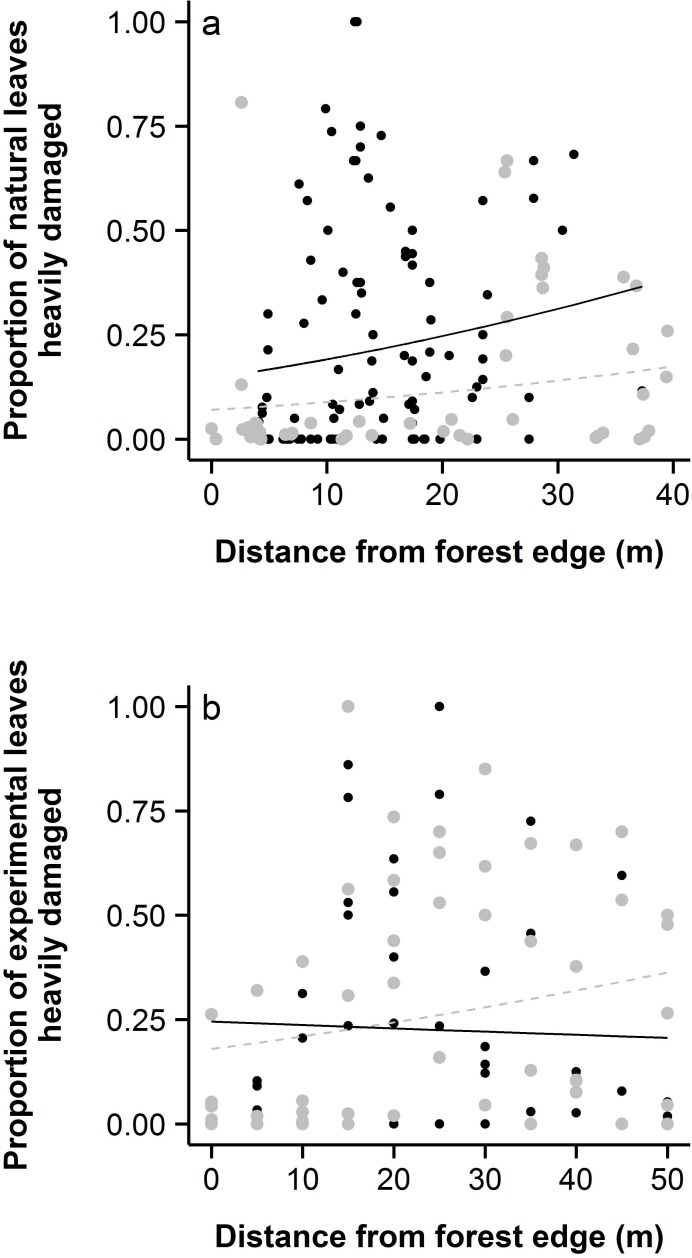
Distance from forest edge altered patterns of beetle damage in both (A) natural populations and (B) the transect experiment.Gray points indicate H. perforatum, with a dashed gray line indicating the fit between the proportion of leaves heavily damaged and distance from the forest edge. Black points indicate H. punctatum, with a solid black line indicating the fit between the proportion of leaves heavily damaged and distance from the forest edge.